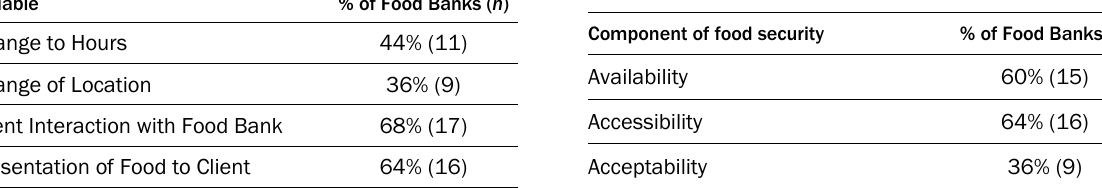
Table 2. Proportion of Seattle Food Banks ( N =25) that Communicated Any Operational Changes Due